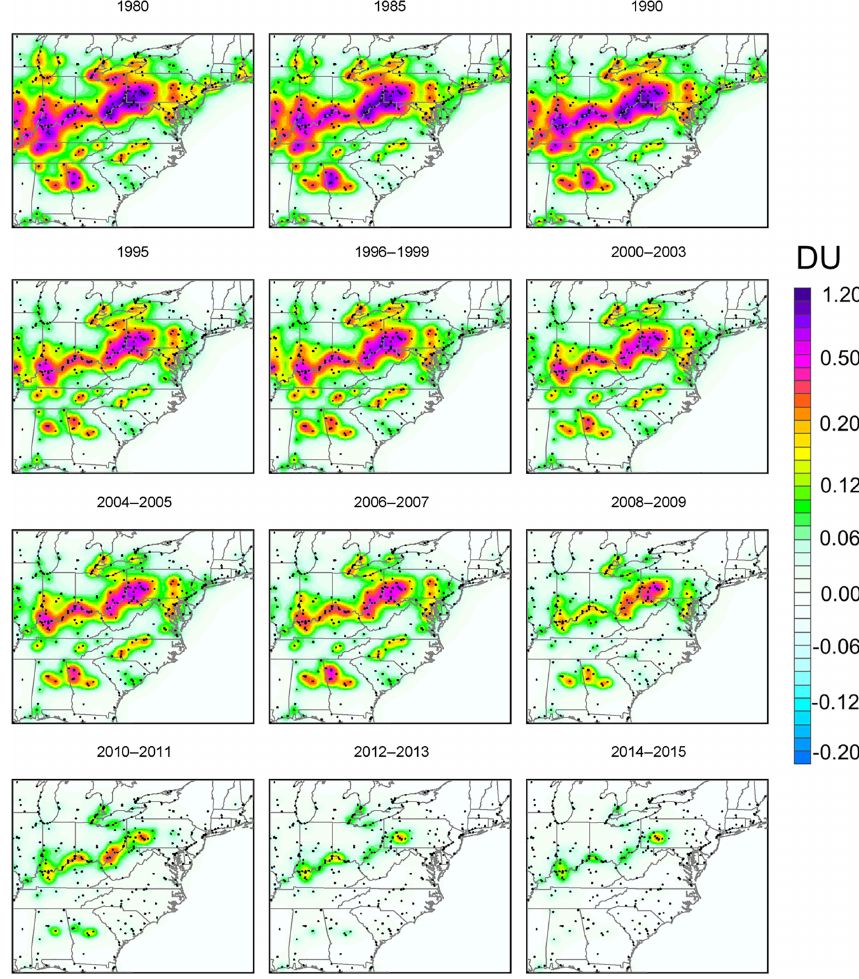
Figure 7. Annual mean SO 2 VCD calculated using the plume model applied to the reported emission data. Annual emission data from ∼ 380 SO 2 sources (black dots) that emitted 1ktyr − 1 at least once in 2005–2015 were included in the calculations. The area 30 to 48 ◦ N and 70 to 90 ◦ W is